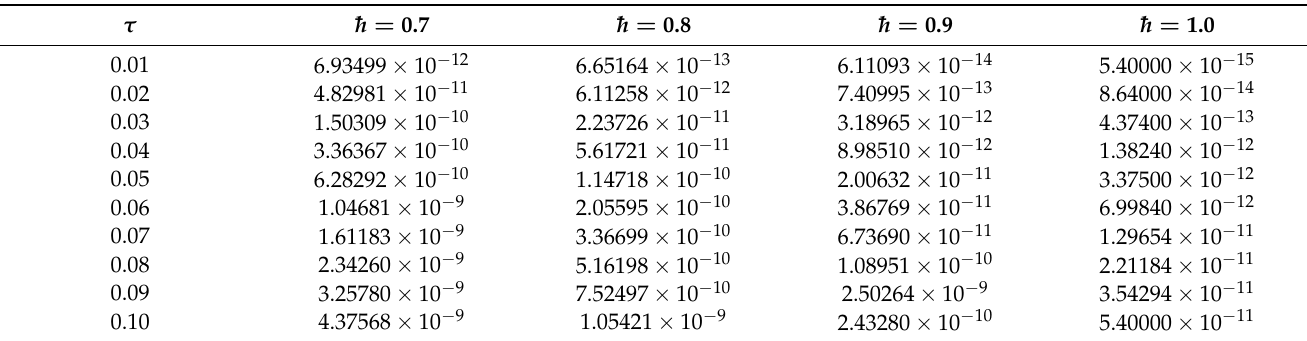
Table 4. The | Ω 4 ( α , τ ) − Ω 3 ( α , τ ) | of Problem 2 at varying values of ¯ h at α = 1.0 determined by the ARPSM at plausible locations in the range τ ∈ [ 0, 0.10 ] .